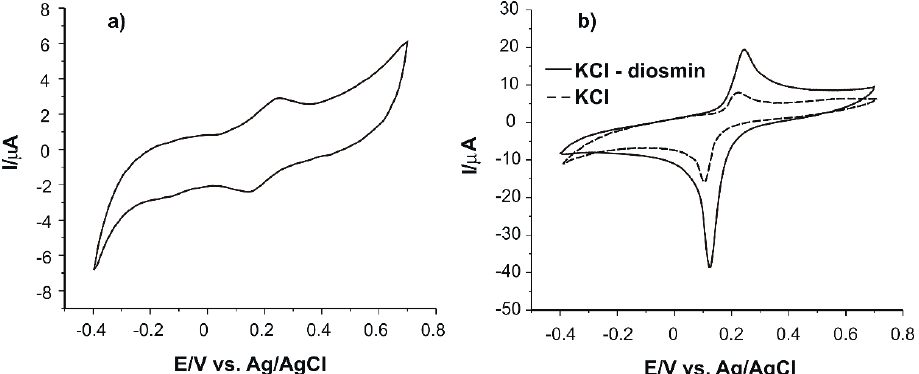
Figure 3. ( a ) CV of SPCE immersed in a double solution of 10 − 3 M diosmin/KCl 10 − 1 M; ( b ), CVs of PB/CSPE immersed in 10 − 4 M diosmin/KCl 10 − 1 M solution (solid line) and in KCl 10 − 1 M solution (dashed line). Table 4. Electrochemical parameters obtained by analyzing the double 10 − 4 M diosmin/KCl 10 − 1 M solution. Electrode